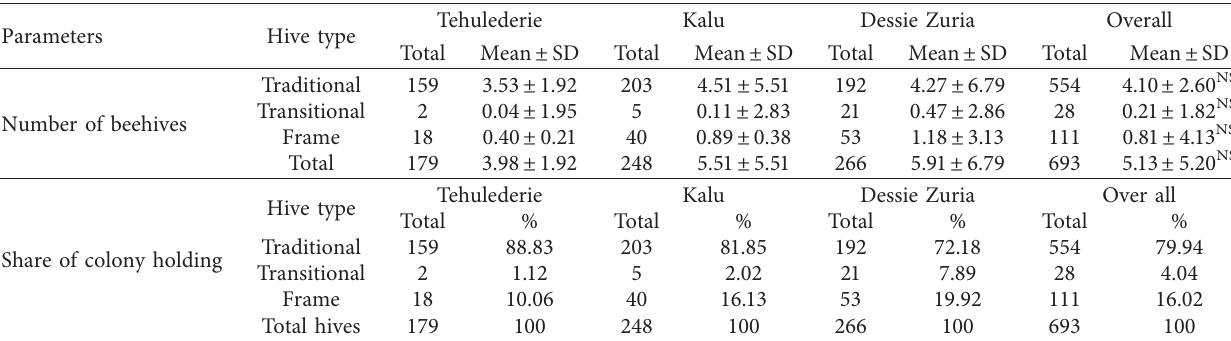
Table 6: Honeybee colony holdings and share of colony holding.